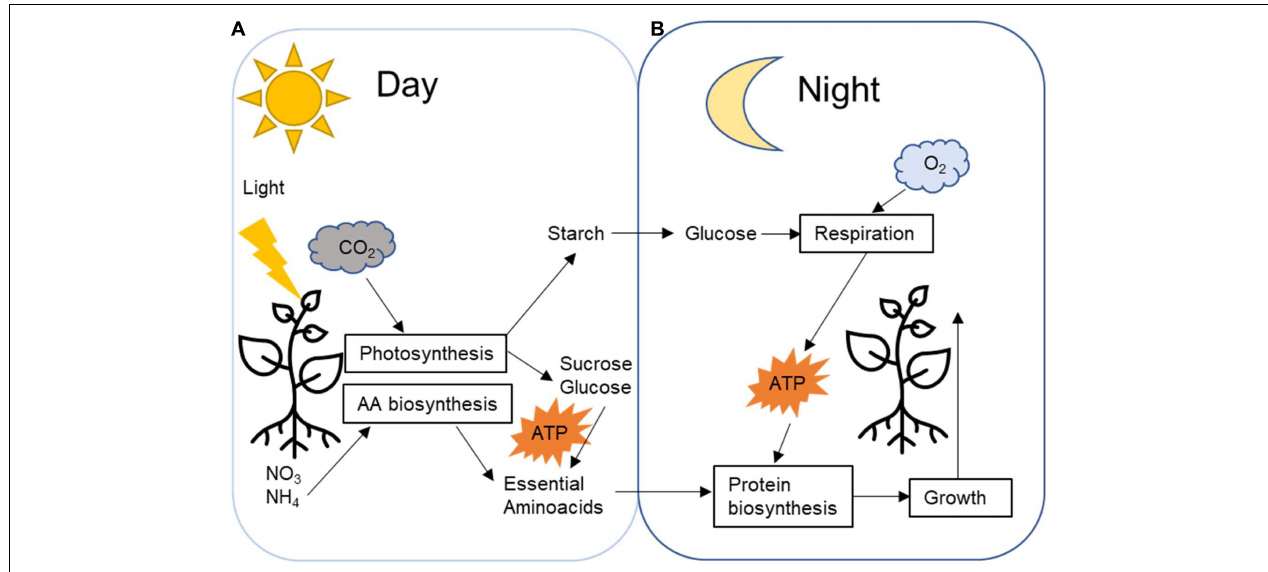
FIGURE 2 | Plant daily transitory starch carbon management processes. (A) During the day, CO 2 is fixed by the Calvin cycle generating sugar that will be promptly utilised as an energy source for day metabolism, such as nitrite and nitrate fixation and amino acids biosynthesis. Part of the fixed carbon is temporarily stored in the plastids as starch. (B) During the night, starch is broken down into glucose that respiration will generate energy for nighttime metabolism reactions, such as protein biosynthesis and plant